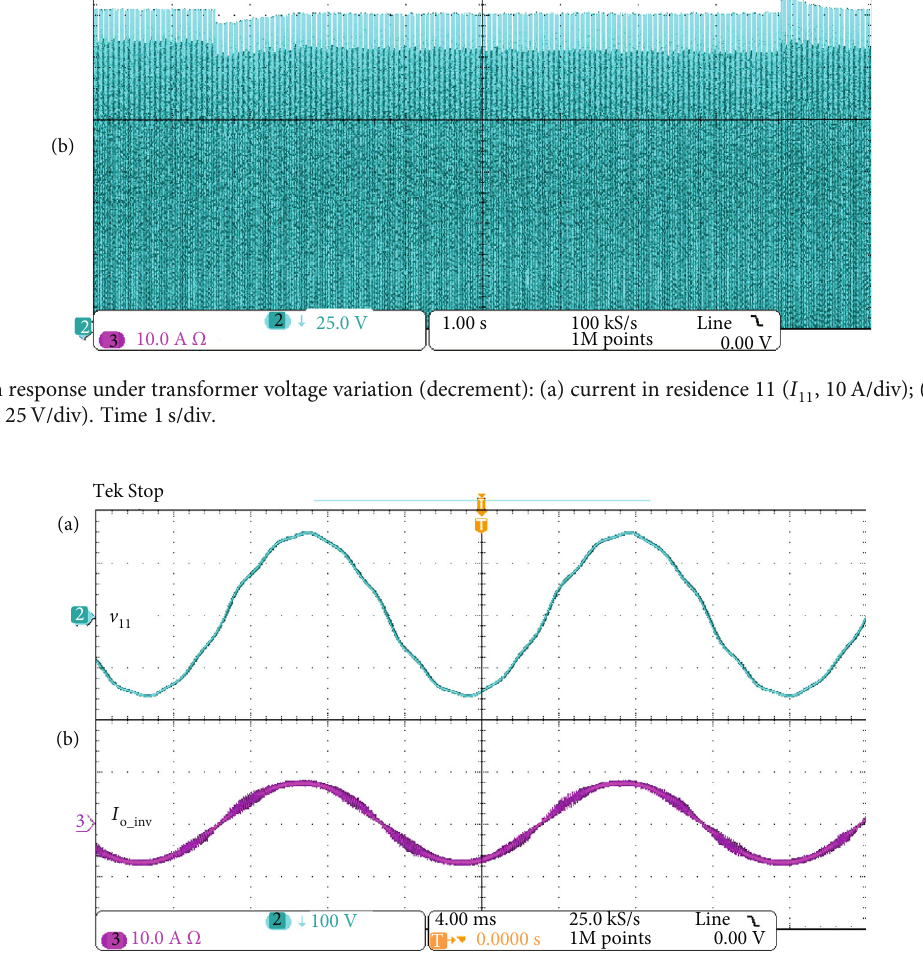
, 100 V/div); (b) current in residence 11 ( I 11